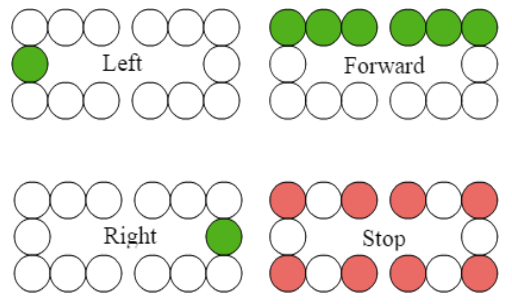
Figure 4. Four main navigational commands correspond to combination of